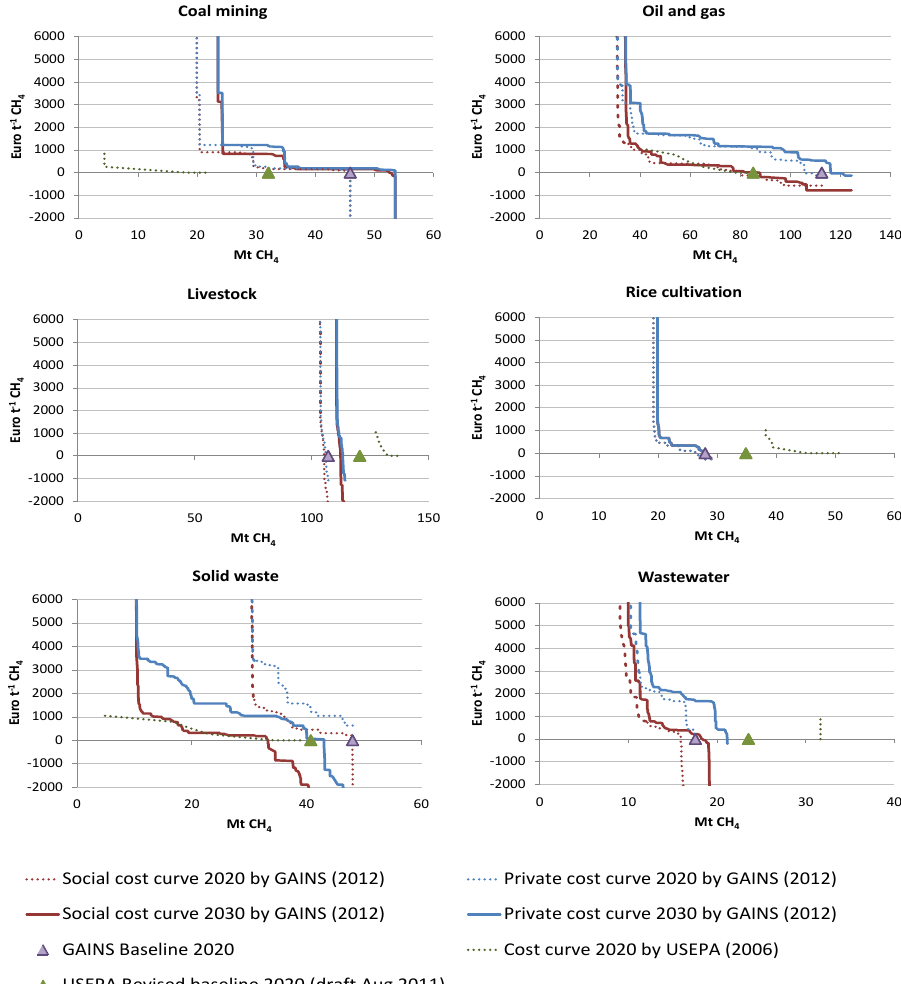
Fig. 8. Global CH 4 mitigation cost curve 2020 and 2030 by sector with private and social cost perspectives and in comparison to USEPA